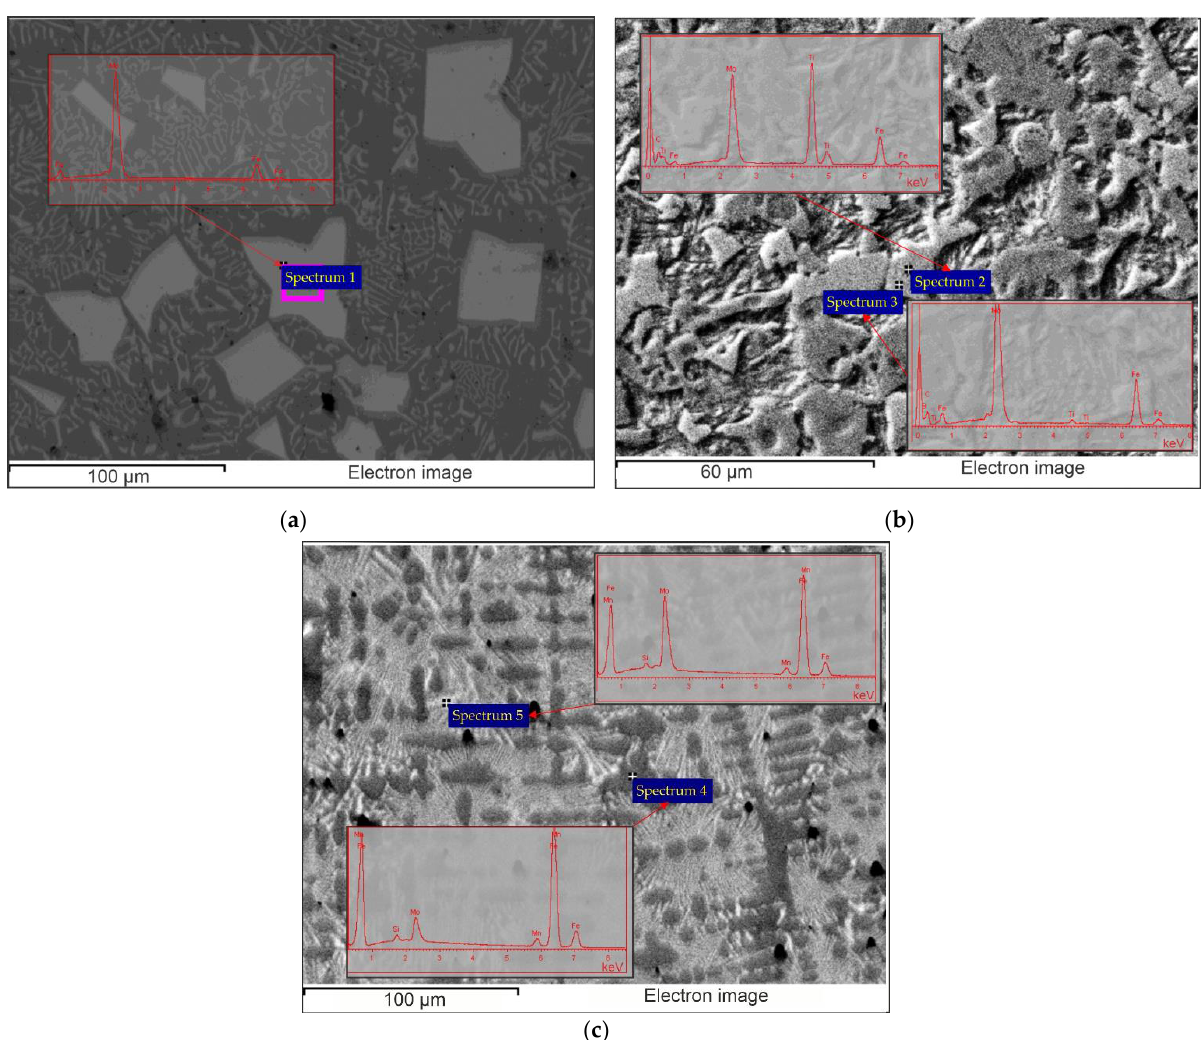
Figure 8. The local areas of the EDS analysis and the corresponding spectra: ( a ) Sample 1; ( b ) Sample 2; ( c ) Sample 3. Table 6. Results of the EDS analysis at the local areas from Figure 9.